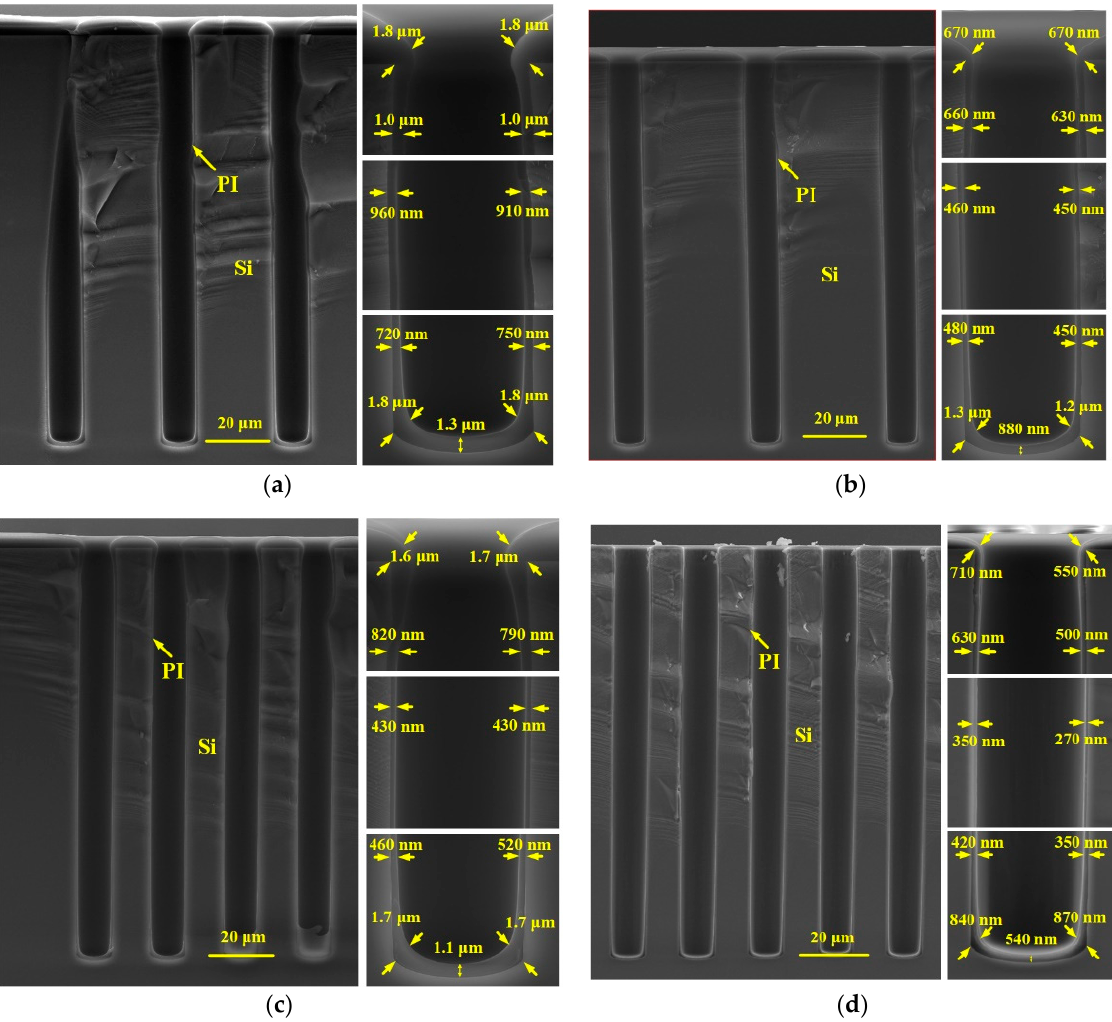
Figure 7. Cross sectional SEM images of PI liners deposited by vacuum-assisted spin coating technique: ( a ) 2000 rpm for 20 s, ( b ) 2000 rpm for 40 s, ( c ) 2000 rpm for 60 s, ( d ) 3000 rpm for 40 s.